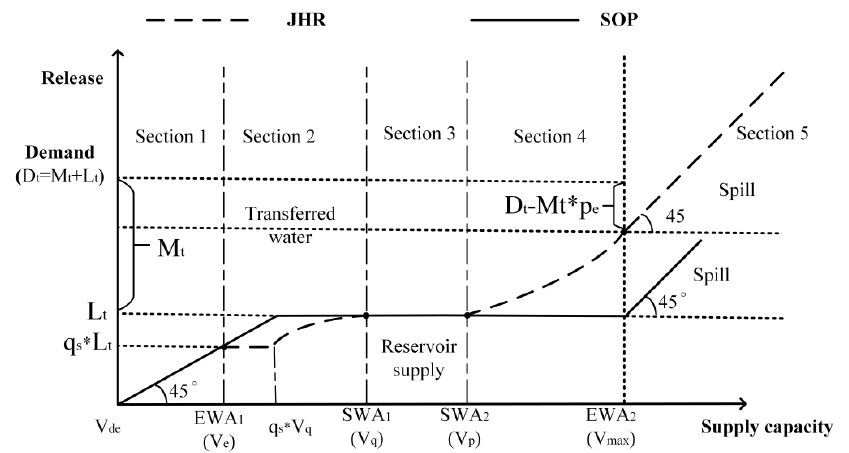
Figure 4. Comparison of curves of JHR and SOP. Table 1. Supply process of JHR.